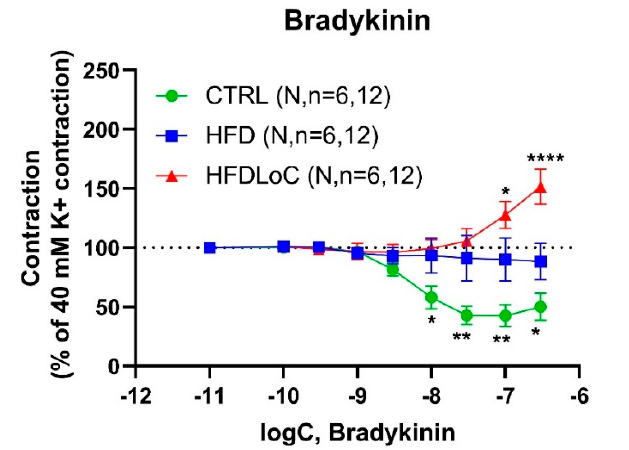
Figure 3. Concentration–response curves to bradykinin in guinea pig coronary arteries contracted by 40 mM K + . Results are expressed as percent change from the plateau contraction to 40 mM K + . * Significantly different from HFD. Mean ± SEM, * p < 0.05, ** p < 0.01, **** p < 0.0001 HFDLoC or CTRL vs. HFD determined by 2-way ANOVA and Tukey’s multiple-comparisons test. N, number of animals; n , number of investigated segments.